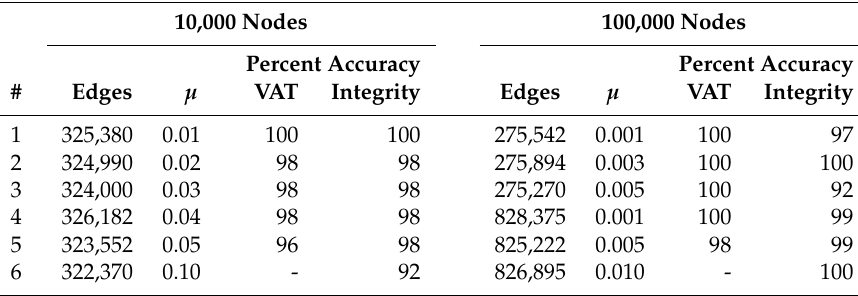
Table 4. Clustering Results for LFR Nets of 10,000 and 100,000